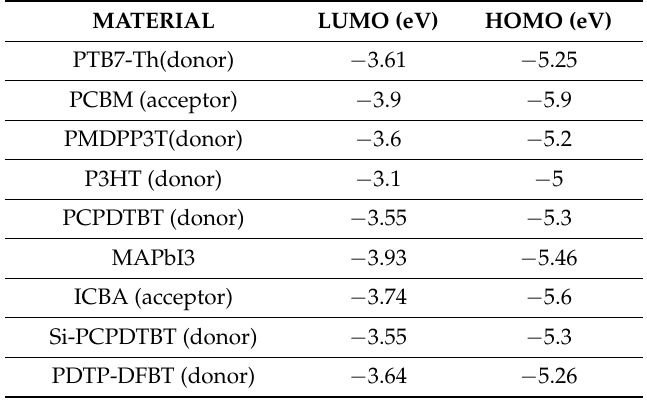
Table 2. The HOMO and LUMO level of donor and acceptor of materials used in the simulation [13]. MATERIAL LUMO